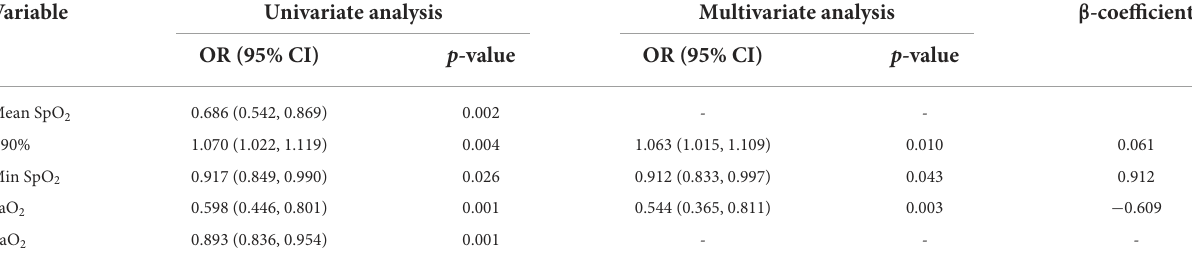
TABLE 4 Hypoxemia-related indicators associated with female CTEPH.